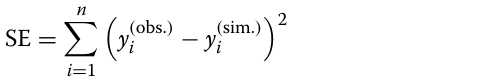
were landslide deposition and tsunami propagation.